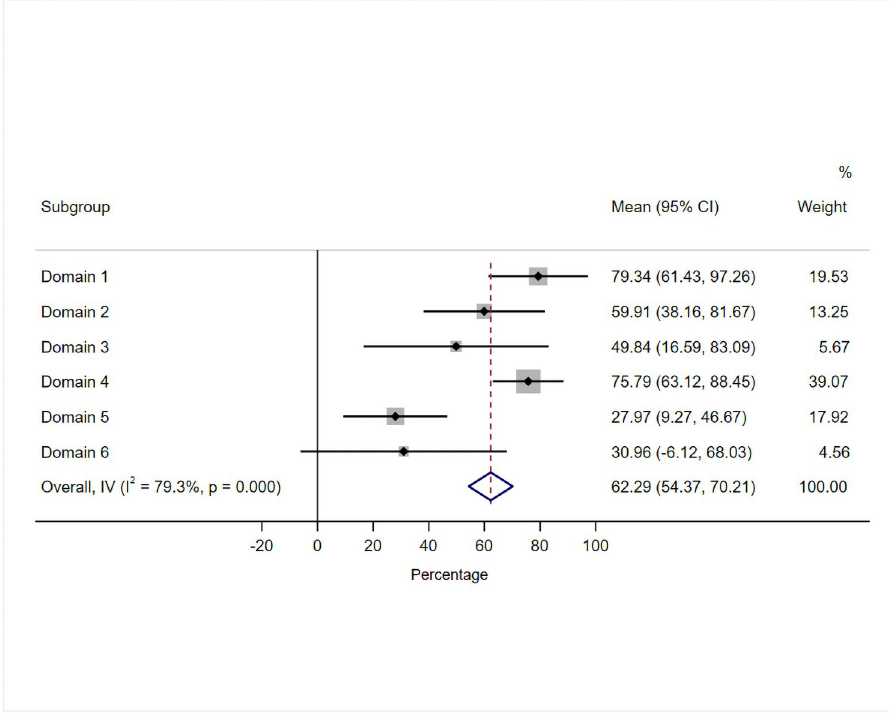
Fig 2. Mean standardised AGREE II domain scores of included guidance documents using a forest